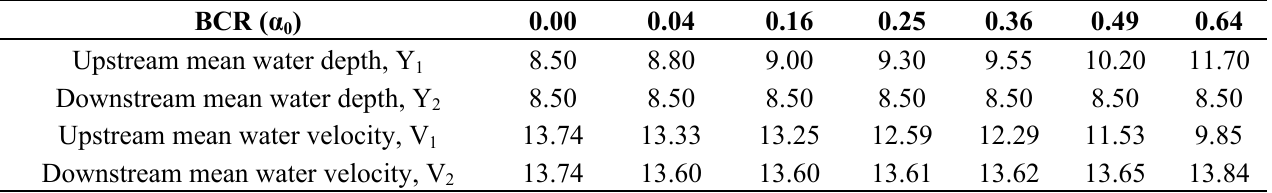
Table 1. Water depths (unit: cm) and velocities (unit: cm/s) in different building coverage ratio (BCRs).